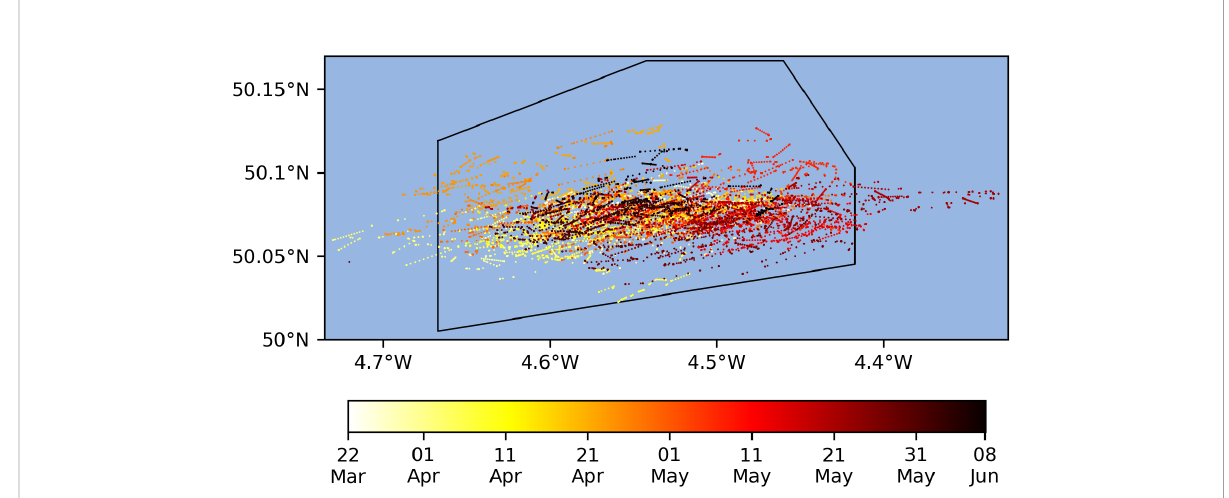
FIGURE 3 Reported surface positions of the glider (colored dots). The black polygon shows the region to which the glider waypoints were